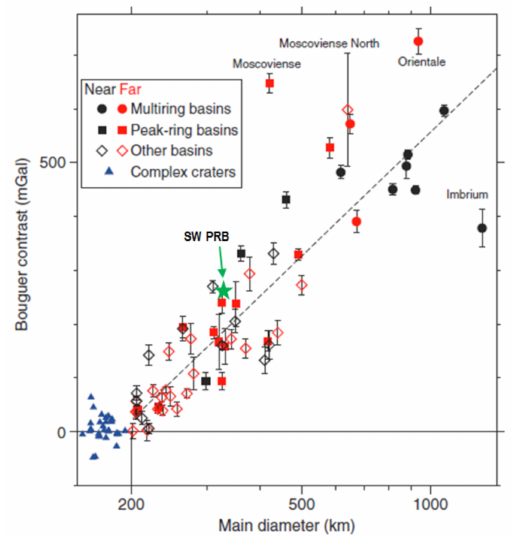
Figure 3. Bouguer anomaly contrast versus main ring diameter (log scale) on the near-side and far-side of the Moon [13]. Open symbols represent possible basins in which multiple rings are not preserved. Green star is the candidate peak–ring basin in southwest of the Orientale basin. The rate of increase in Bouguer anomaly contrast given by a log-linear least squares fit to diameter (dashed line) is about 240 mGal per factor of 2 increase in